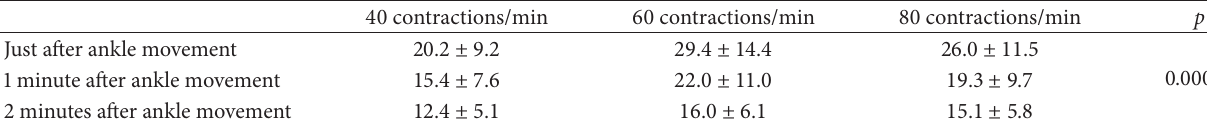
Table 3: Postoperative mean velocity of blood flow of profunda femoris measured two days after total hip arthroplasty. 40 contractions/min 60 contractions/min 80 contractions/min p Just after ankle movement